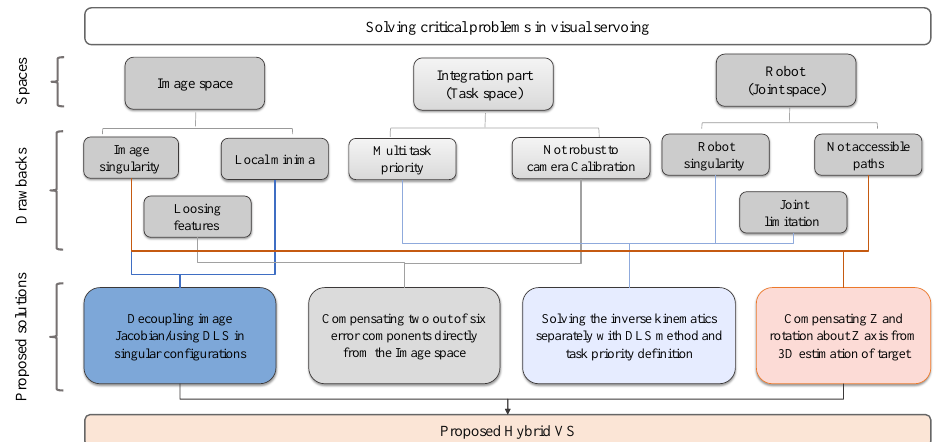
Figure 2. Schematic diagram of problem domains in visual servoing. The proposed DHVS method reduces the image and robot singularity configurations, and keeps the robot away from the joint limits. In addition, it is less likely to lose the object from the camera FOV, and it is more robust to the camera calibrations than PBVS method (It generates controllable trajectories with a higher amount of robot Jacobian, resulting in better